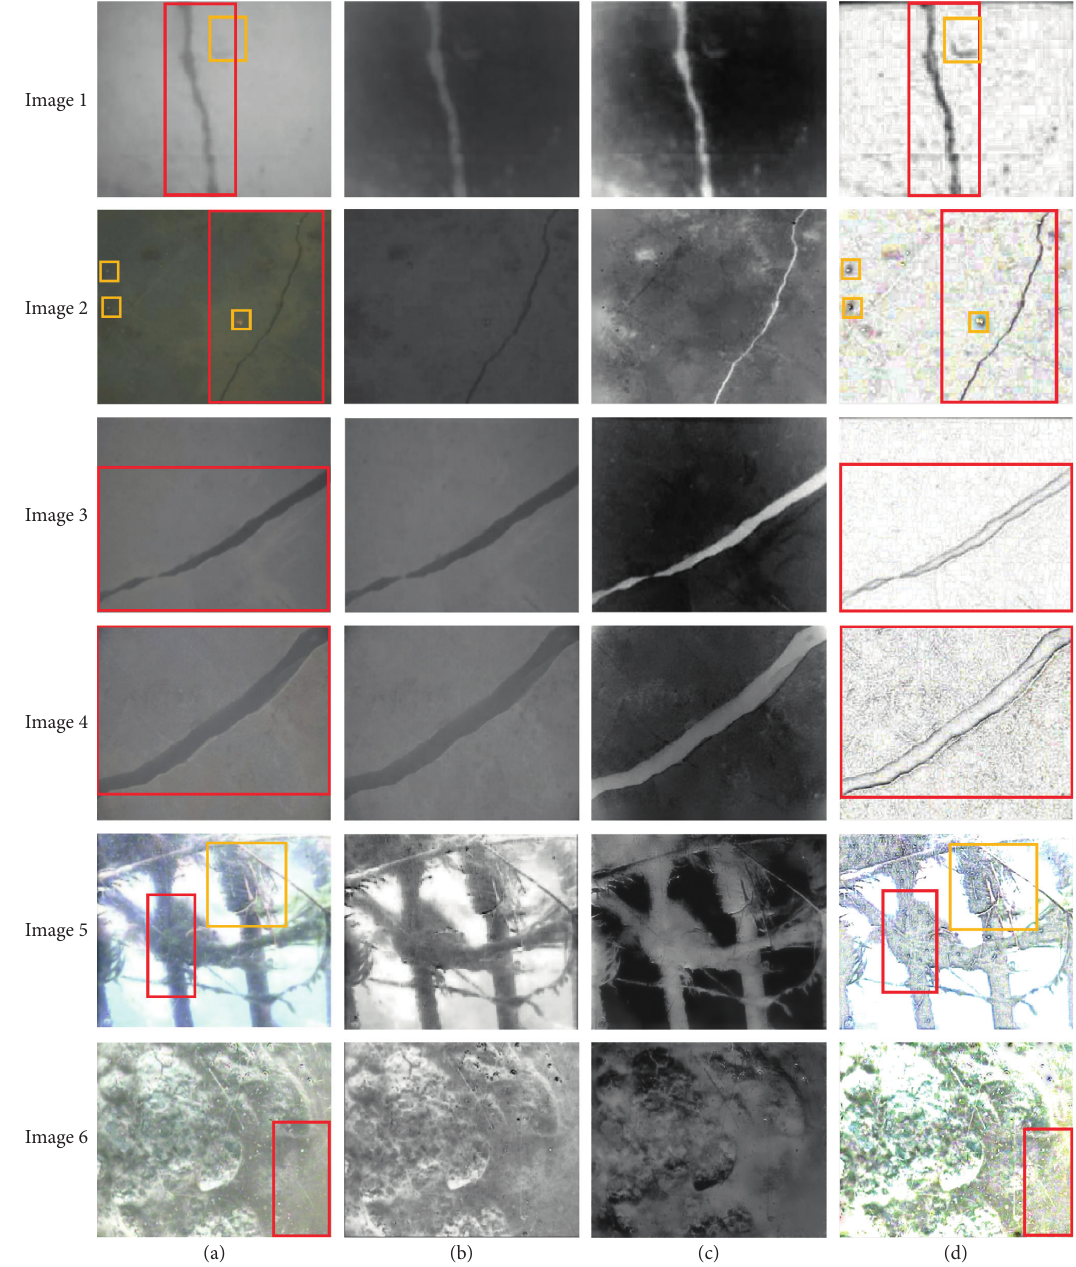
Figure 5: Image results. (a) Original image collected. (b) After the minimum RGB image is removed. (c) Transmittance distribution of the image. (d) Image processed by the DR